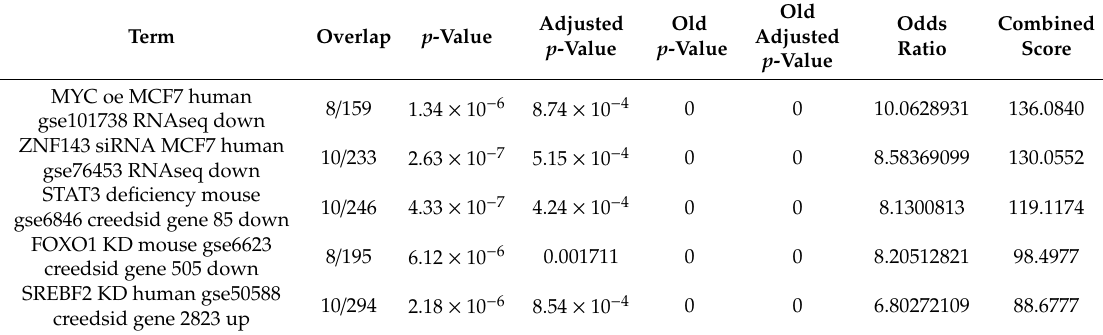
Table 2. Bufalin gene set enrichment analysis.